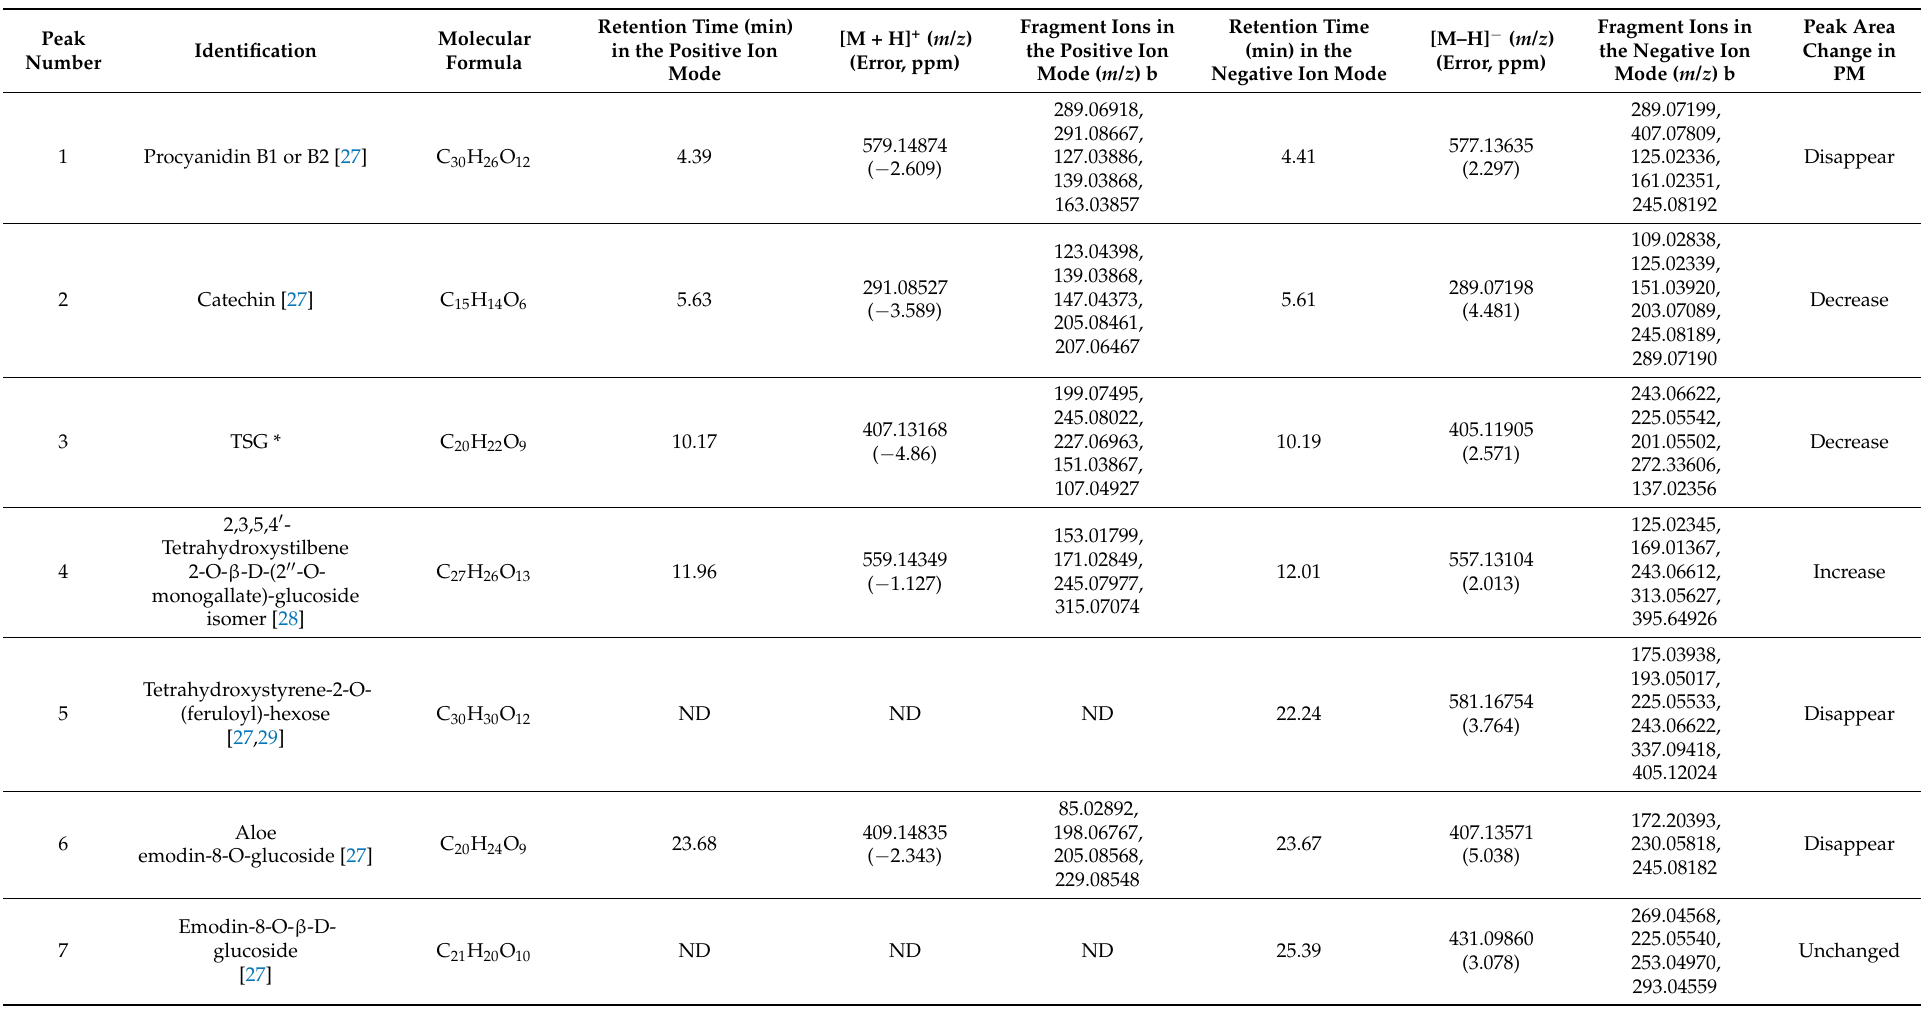
Table 1. Results of changes in the chemical constituents of PM after